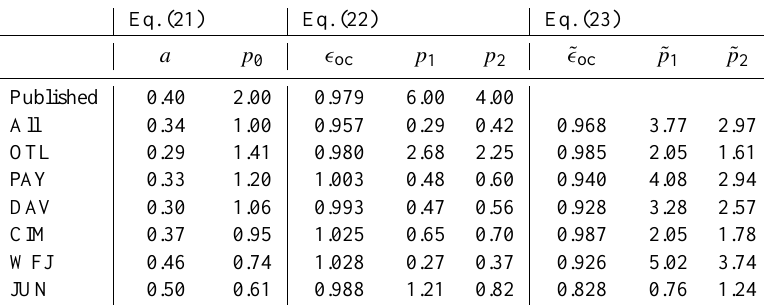
Table 5. Fitted parameters of the all-sky LDR parameterizations presented in Eqs. 21, 22 and 23. The clear-sky emissivity is estimated according to Konzelmann et al. (1994). The second line consists of the estimates when all stations are fitted simultaneously, while the first indicates the values estimated by Pirazzini et al.